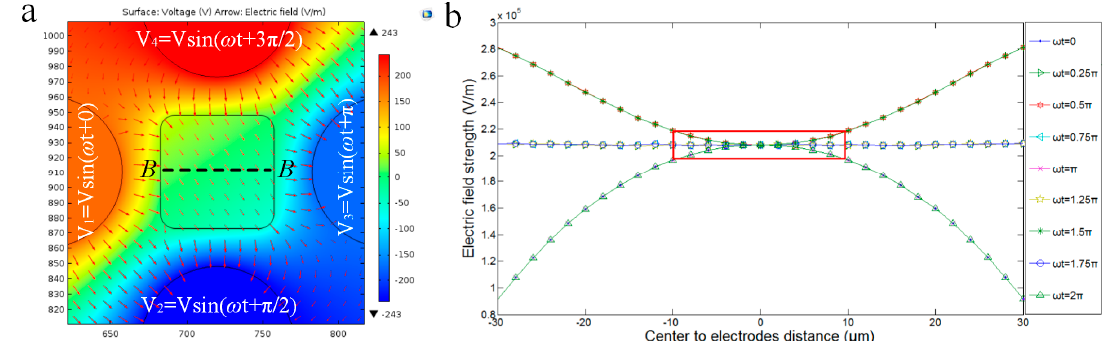
Figure 4. The electric field distribution in the electrode chamber. ( a ) The top view of the electric field distribution of the chamber. ( b ) The electric field strength of the center cutline, B–B, of the chamber. The red solid rectangular box indicates that the field distribution exhibits about 20% variation and the cell in the region can maintain a stable rotation.